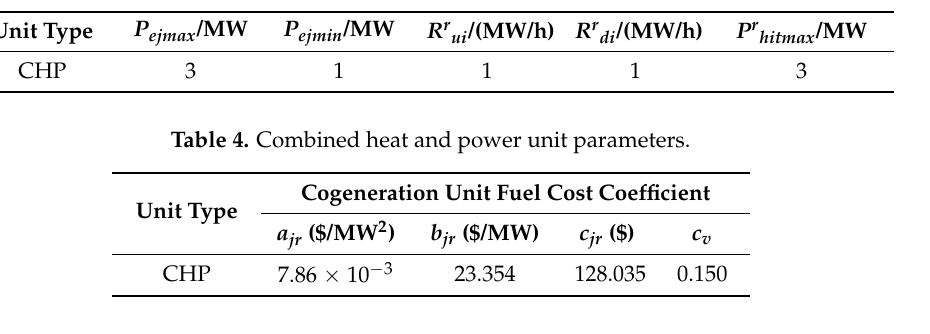
Table 5. Data of storage